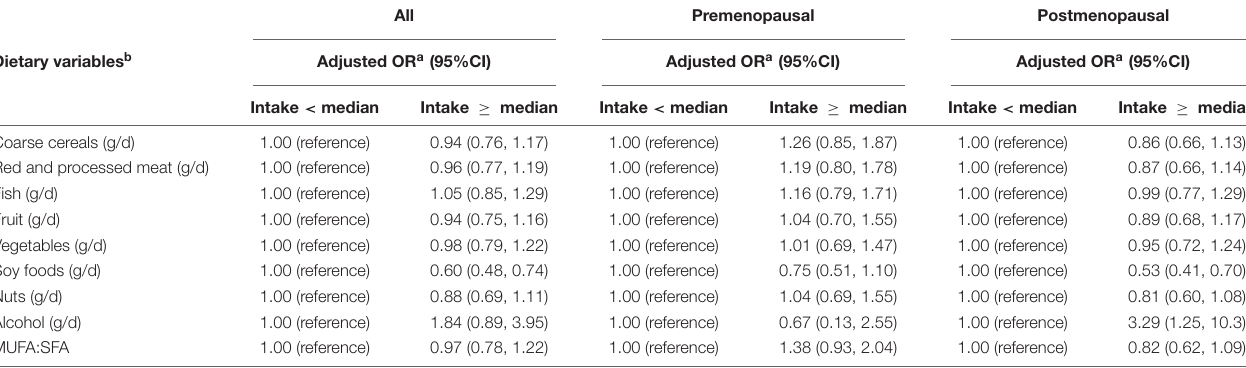
TABLE 4 | Associations (OR and 95%CIs) between separate foods component of the vegetable-fruit-soy dietary pattern and breast cancer, stratification by menopausal status.